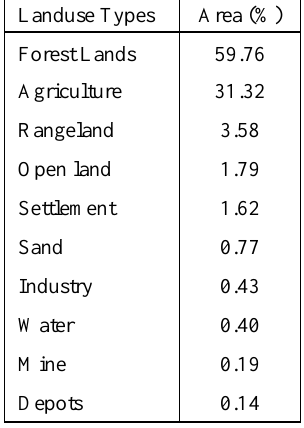
Table 3. Areal distribution of landuse types